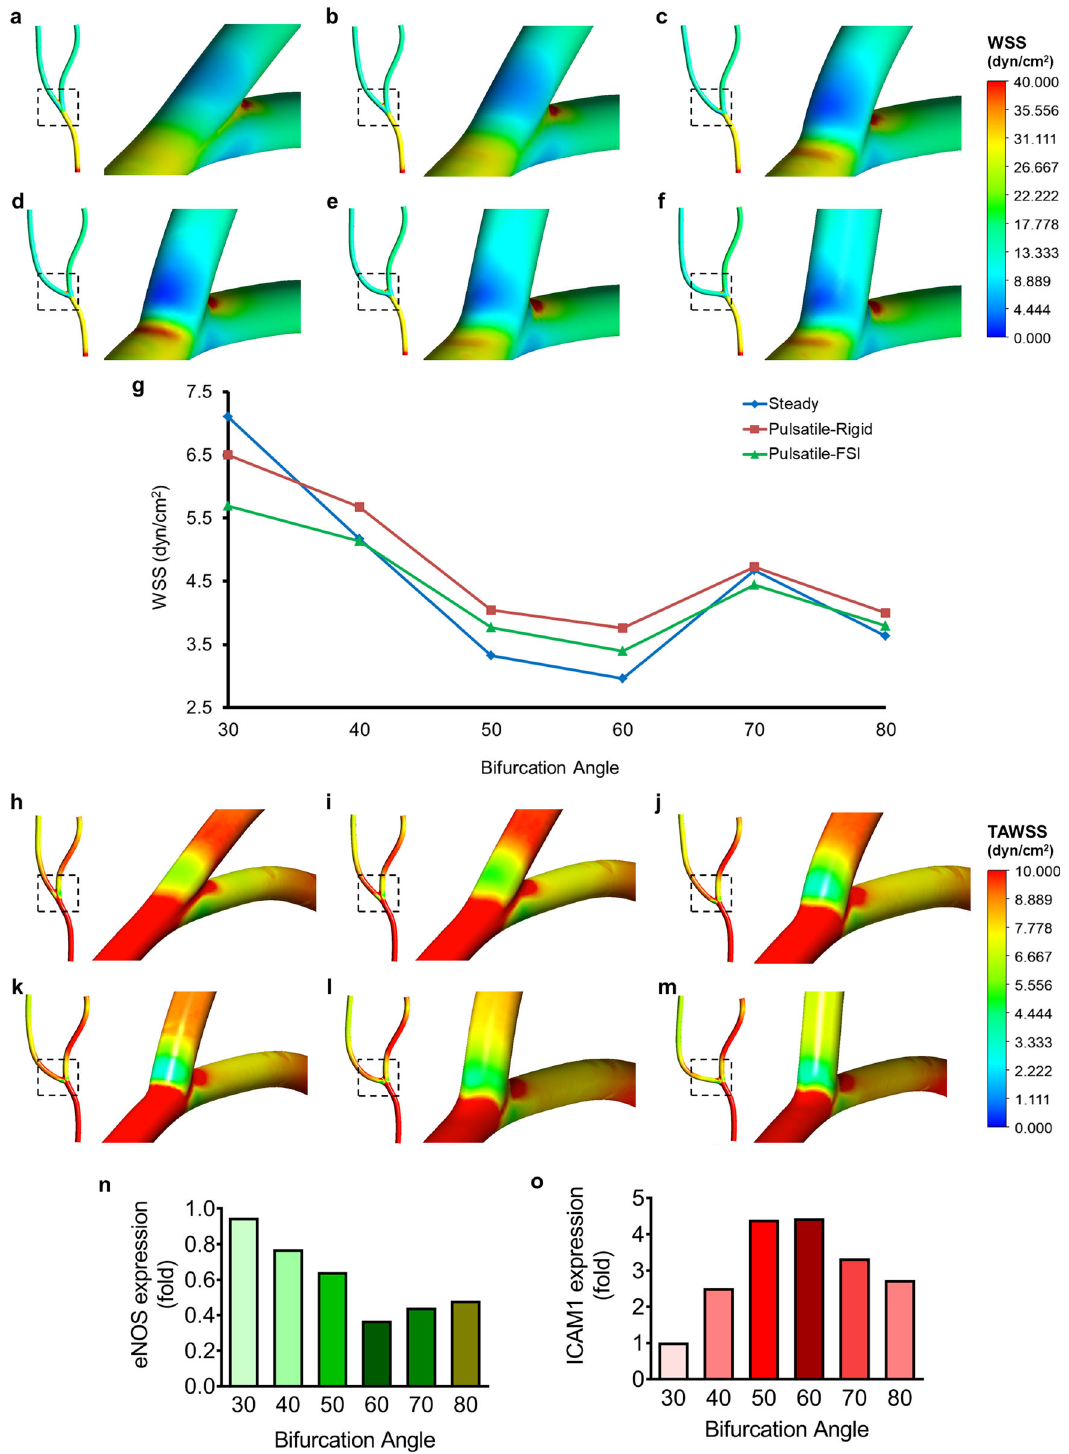
Fig. 1 Increasing angular bifurcations of coronary artery creates regions with low WSS and alters biochemical signatures of EC experiencing D-Flow. a – f WSS contours of steady-state fl ow simulations in the human coronary artery with bifurcation angles of 30° ( a ), 40° ( b ), 50° ( c ), 60° ( d ), 70° ( e ) and 80° ( f ). g WSS or TAWSS levels under steady-state, pulsatile-rigid and pulsatile-FSI conditions in the D-Flow regions (outer walls of vessel branching point) 30, 40, 50, 60, 70 and 80° bifurcations. h – m TAWSS contours of pulsatile-rigid studies in the bifurcation region of branched coronary artery with angles 30° ( h ), 40° ( i ), 50° ( j ), 60° ( k ), 70° ( l ) and 80° ( m ). n , o Alterations in the protein level expressions eNOS ( n ) and ICAM1 ( o ), with varying angles of vessel bifurcations, in EA.hy926 exposed to 4 h fl ow in the 30, 40, 50, 60, 70 and 80° microchannels.